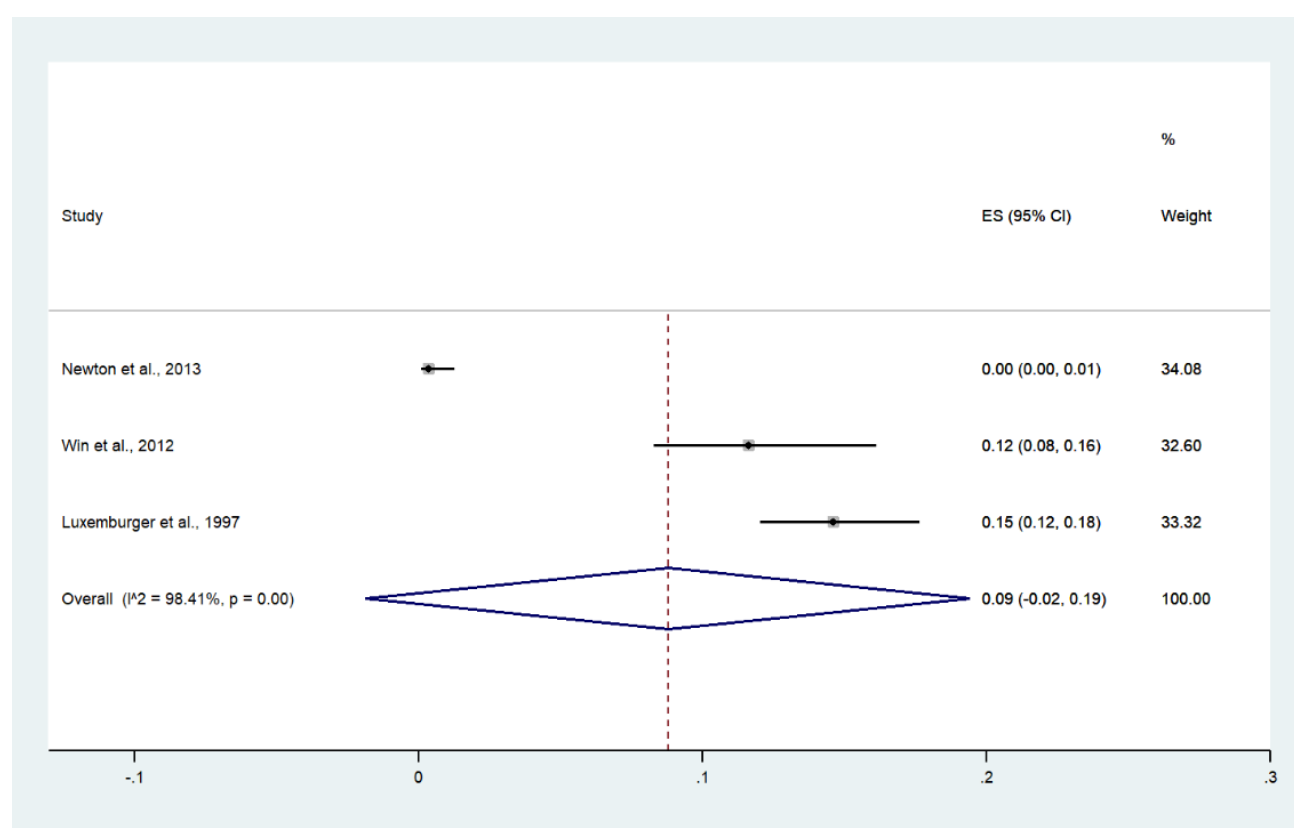
Figure 13. The pooled prevalence of convulsion among patients with severe malaria in Thailand. The label for the x-axis is the scale of estimated prevalence. Abbreviations; ES, estimated prevalence; CI, confidence interval .